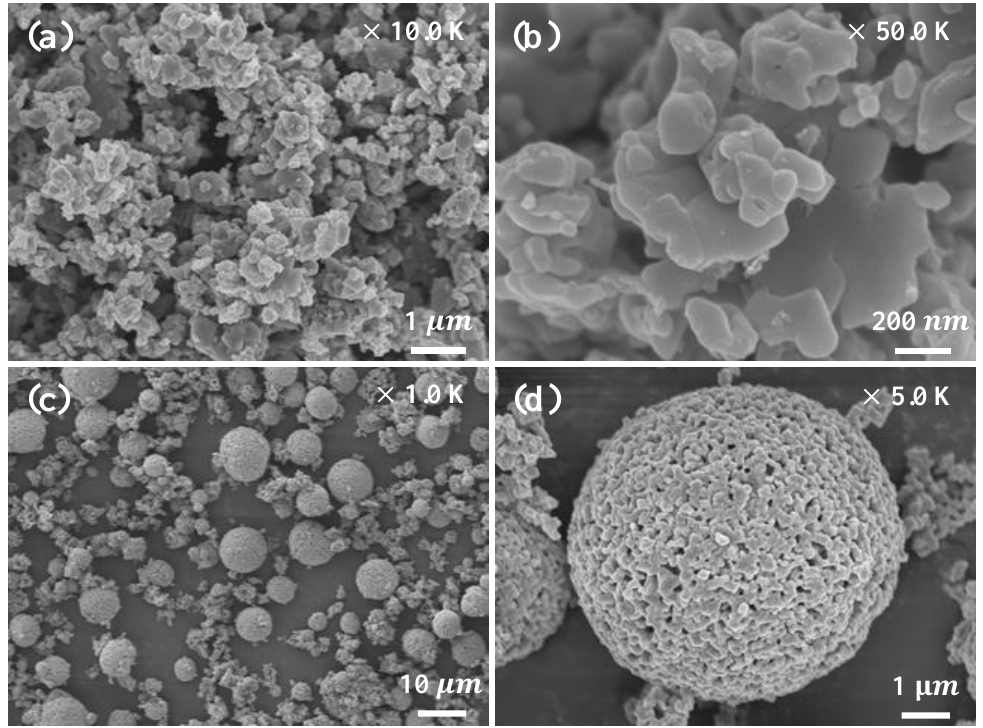
Figure 2. FESEM images of ( a ) and ( b ) LiFePO 4 , ( c ) and ( d ) Li 4 Ti 5 O 12 powders.